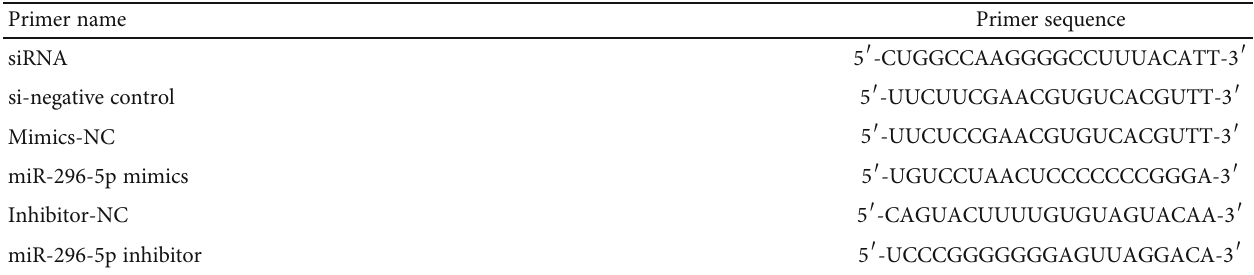
Table 2: The sequence of primer for siRNA.